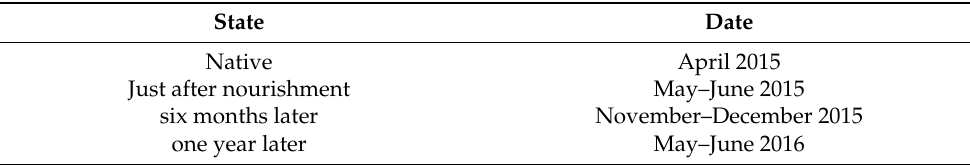
Table 1. Dates of the monitoring campaigns when samples were taken.